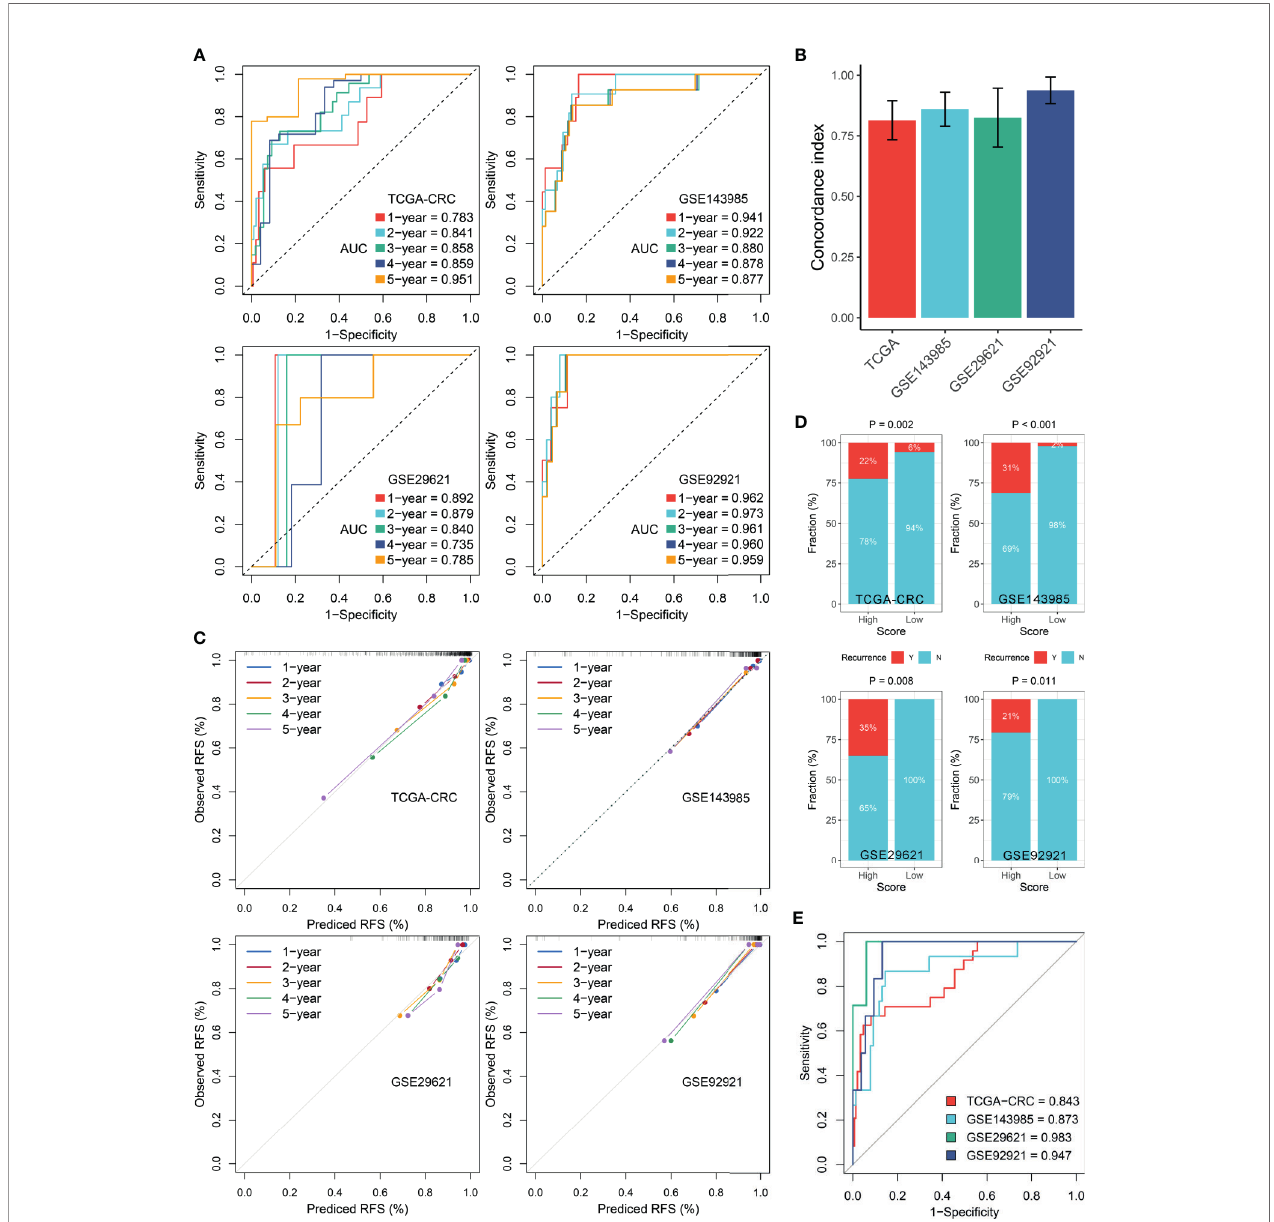
FIGURE 4 | Evaluation of the RAIS model in four cohorts. (A) Time-dependent ROC analysis for predicting RFS at 1~5 years. (B) The Harrell ’ s C-index of RAIS. (C) Calibration plots for comparing the actual probabilities and the predicted probabilities of RFS at 1~5 years. (D) Comparison of recurrence rate between the high- risk and low-risk groups. (E) ROC analysis of the RAIS model for predicting the recurrence event of